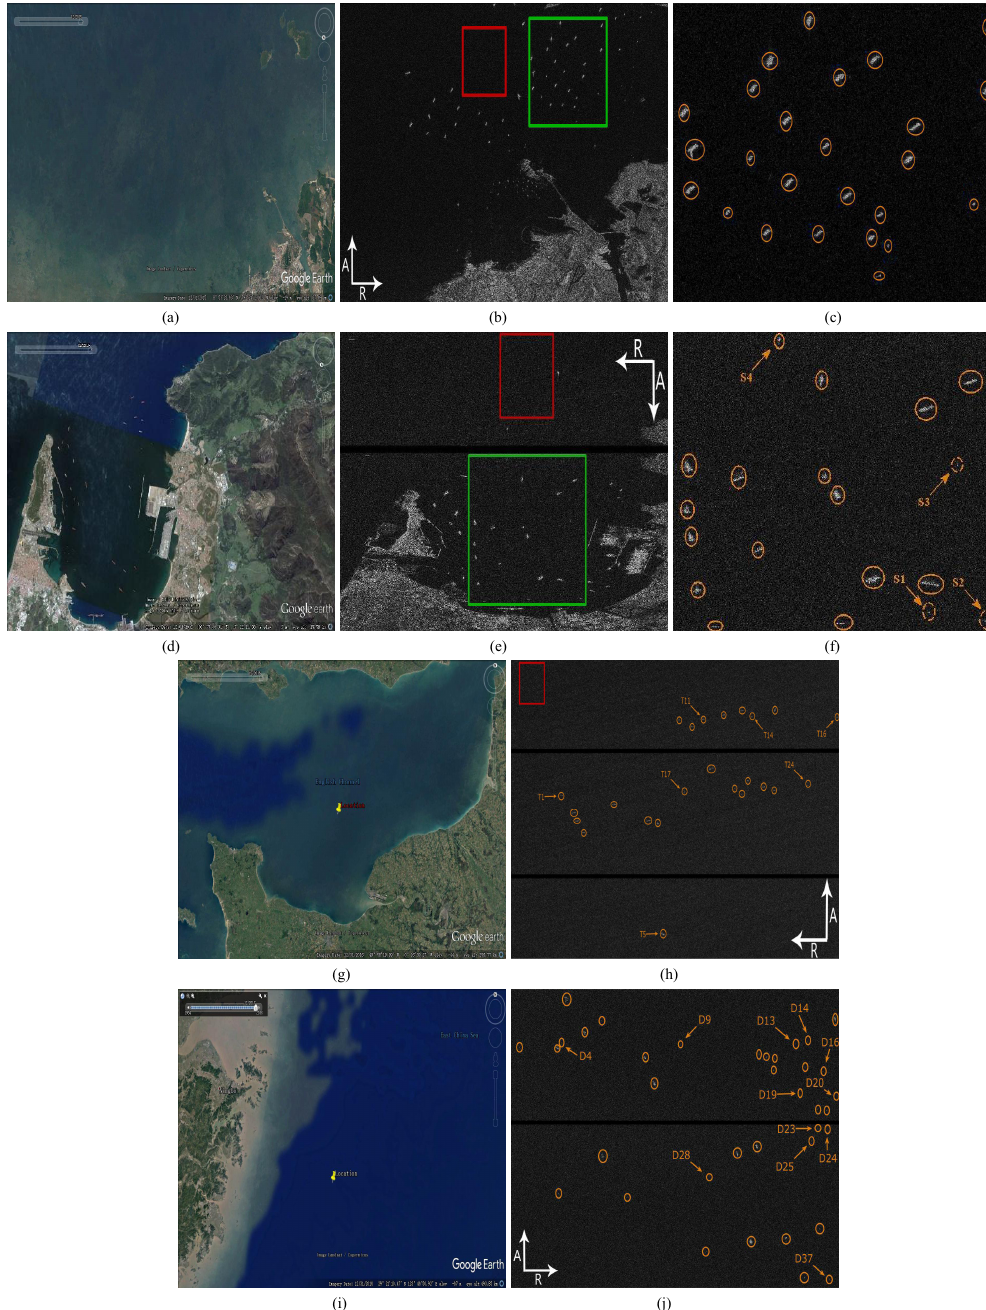
Figure 2. The four datasets. ( a ) the optical image of the first scene; ( b ) the VH image of the first scene; ( c ) the VH image of dataset A (Zoom in the green box of ( b )); ( d ) the optical image of the second scene; ( e ) the VH image of the second scene; ( f ) the VH image of dataset B (Zoom in the green box of ( e )); ( g ) the optical image of the third scene; ( h ) the VH image of dataset C; ( i ) the optical image of the fourth scene; ( j ) the VH image of dataset D. Orange circles indicate the ships. The yellow icons in ( g , i ) represent the locations of ( h , j